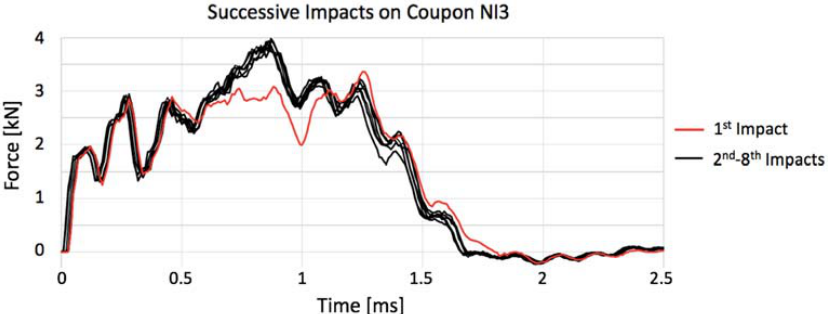
Figure 9. Maximum force in each successive impact event for not ‐ annealed (NI) and annealed (AI) gres.